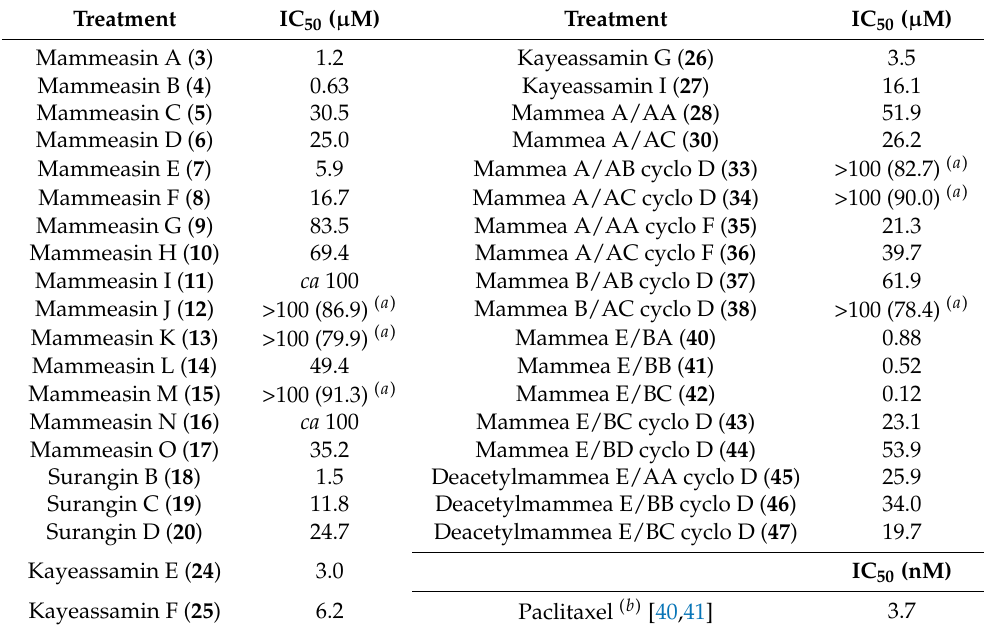
Table 3. IC 50 values of anti-proliferative effects of coumarin constituents ( 3 – 20 , 24 – 28 , 30 , 33 – 38 , 40 – 47 ) from M. siamensis flower against LNCaP